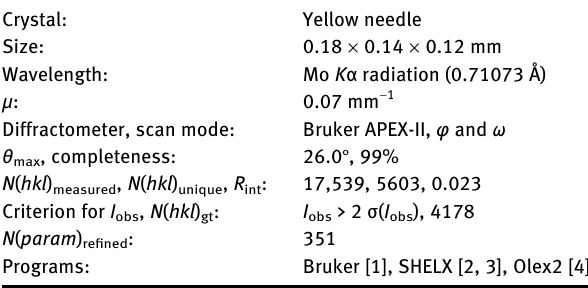
Table  : Data collection and handling. Crystal: Yellow